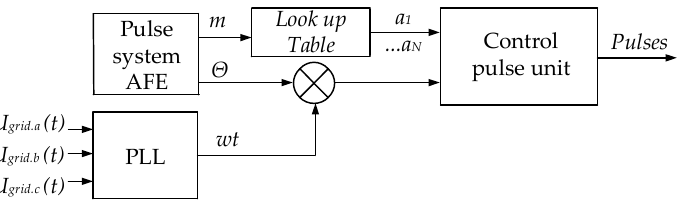
Figure 8. The structural diagram of Selective Harmonic Elimination Pulse Width Modulation.